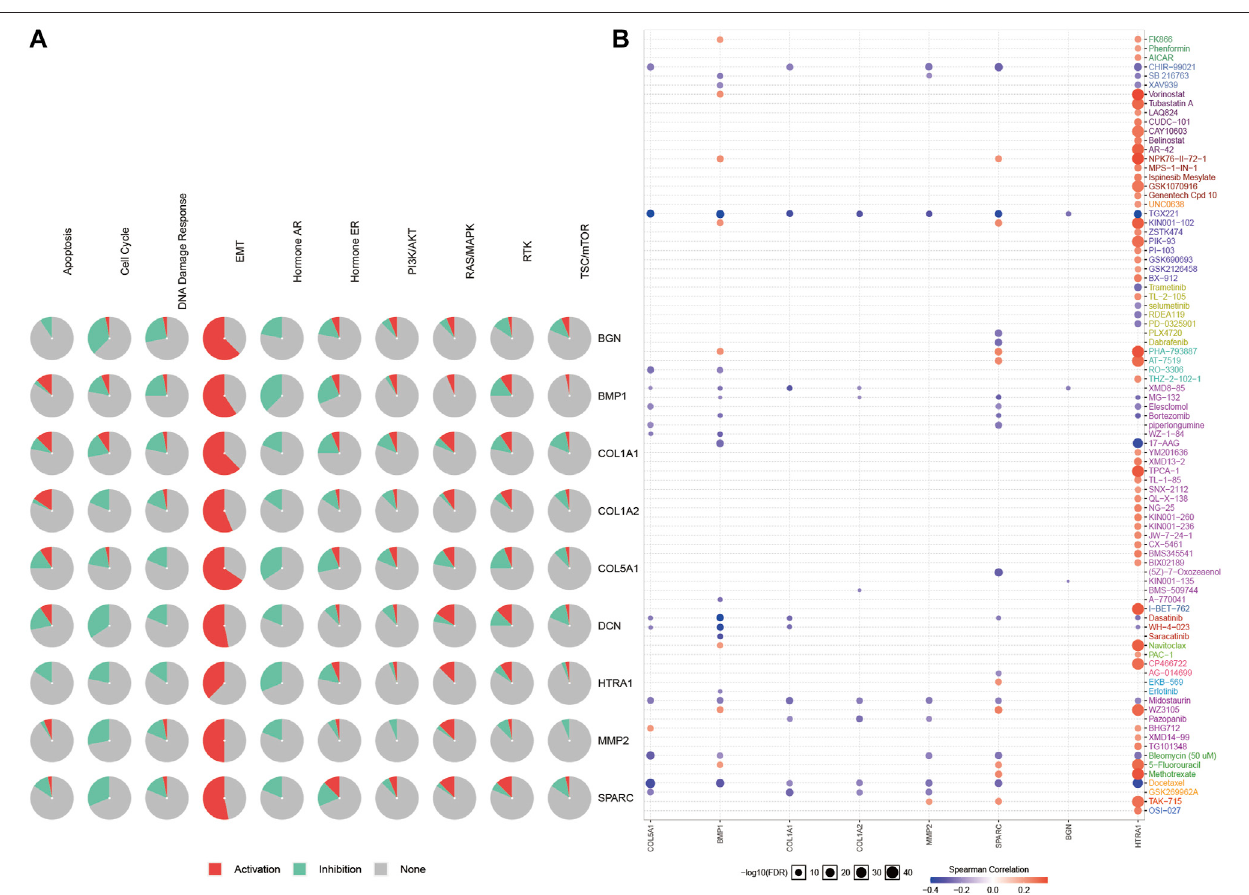
FIGURE9| Pathwayenrichment (A) anddrugsensitivityanalysis (B) of COL1A1 , MMP2 , SPARC , COL5A1 , DCN , BMP1 , BGN ,and COL1A2 basedonGSCALite. The Spearman correlation represented the gene expression that correlated with the drug. Positive correlation means that the high expression of the gene is resistant to the drug, and vice